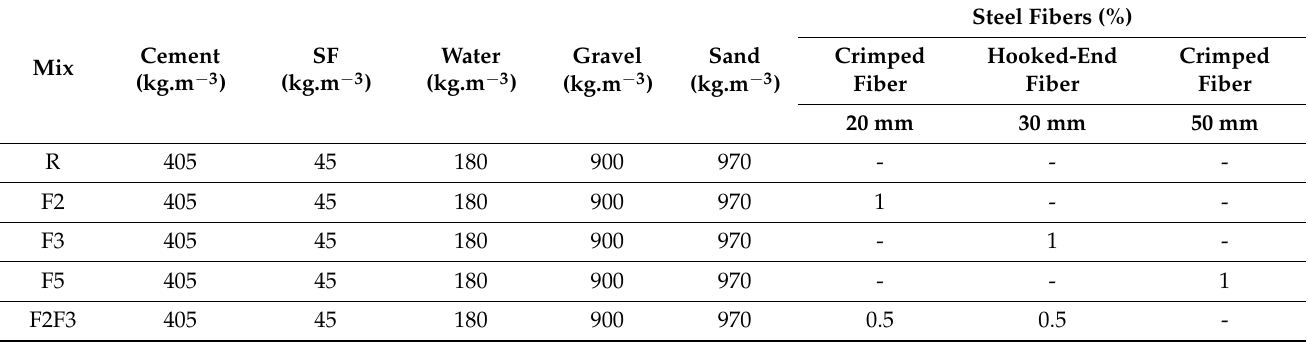
Table 5. Mixed proportions of concrete.